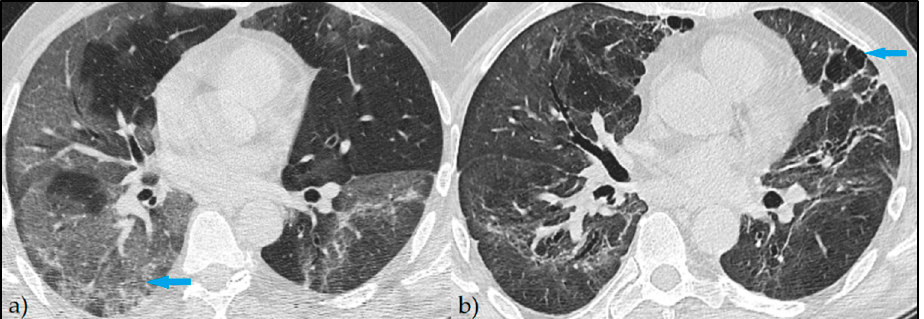
Figure 4. Persistent HRCT findings—Axial HRCT images: ( a ) extensive areas of GGO at the onset of the symptoms (blue arrow); ( b ) persistent areas of fine GGO with bronchiectasis, pleural traction, and pleural thickening at 3 months evaluation (blue arrow).